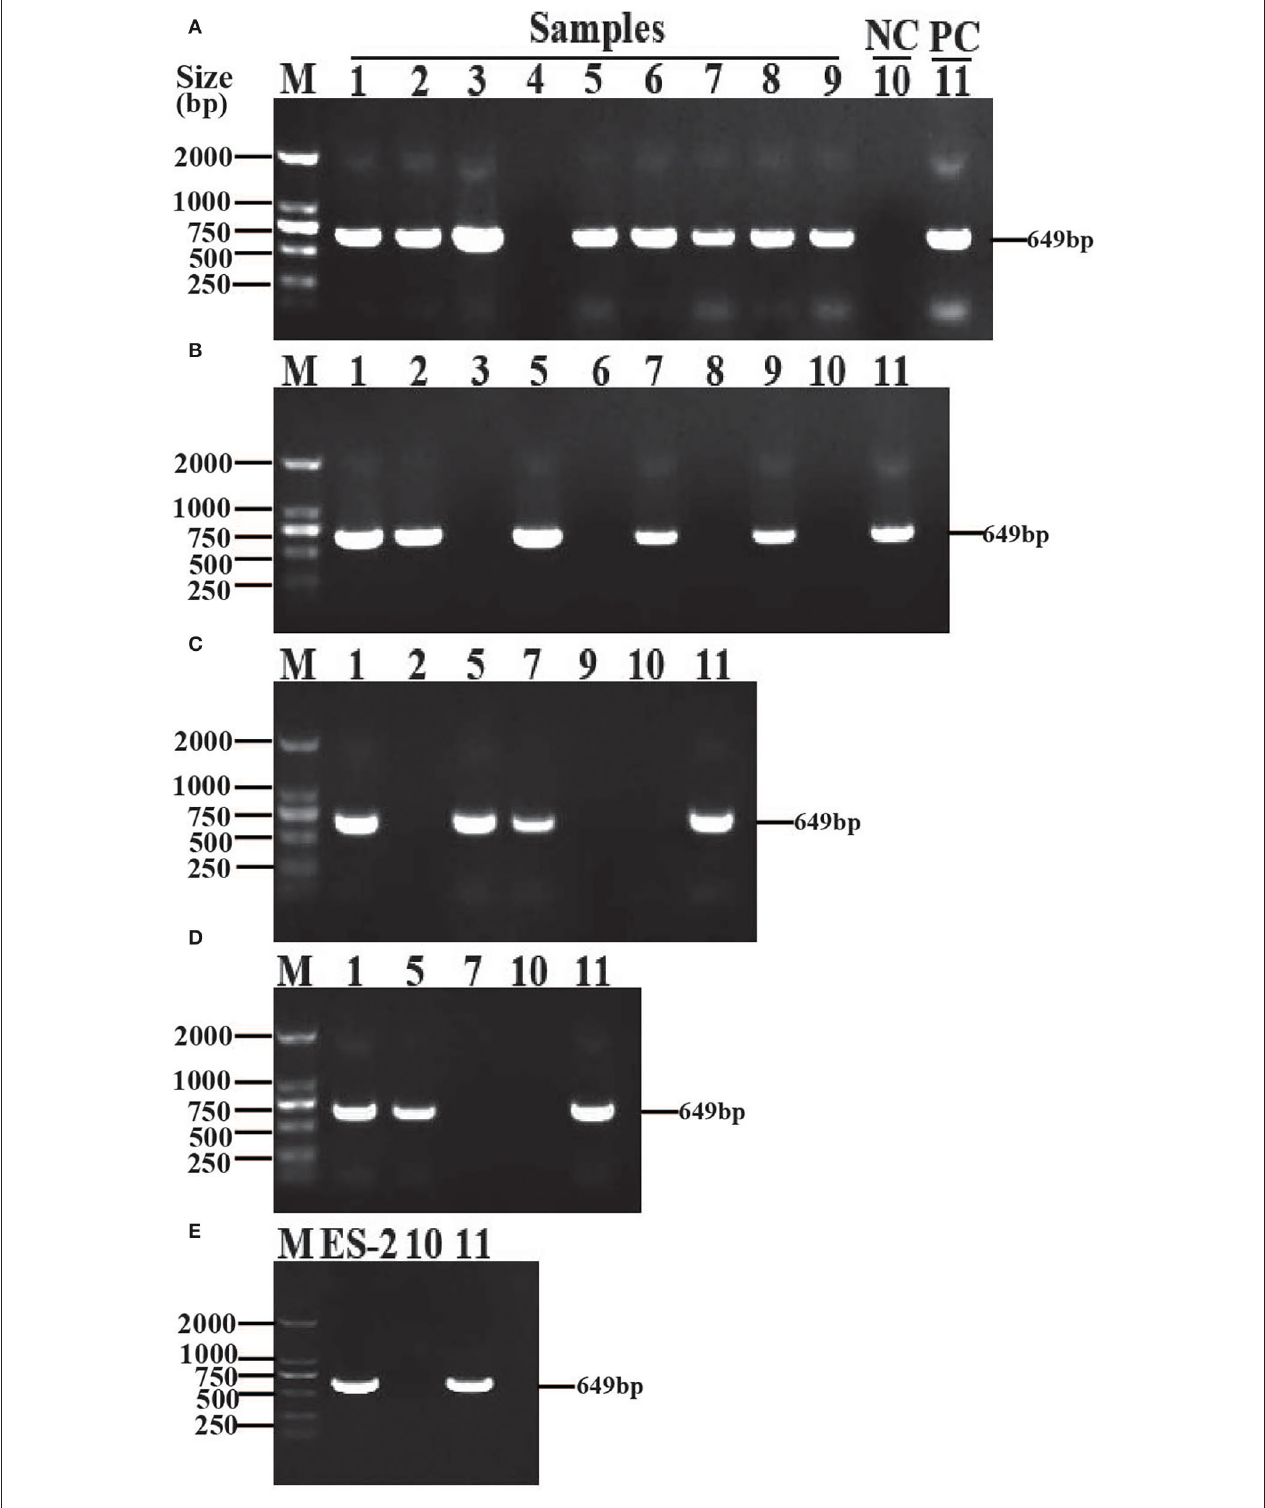
FIGURE 1 | Isolation and identification of M. hyopneumoniae strain ES-2. The samples (1–9) were harvested from different parts of the same lung with gross lesions of EP, M. hyopneumoniae strain ES-2 was isolated by in vitro continuous passage and was confirmed by amplifying the highly conserved 16S rRNA region through PCR with the forward primer 5 ′ -GAGCCTTCAAGCTTCACCAAG A-3 ′ and the reverse primer 5 ′ -TGTGTTAGTGACTTTTGCCACC-3 ′ . (A) The first generation. (B) The second generation. (C) The third generation. (D) The fourth generation. (E) The twentieth generation. M, marker; NC, negative control; PC, positive control.